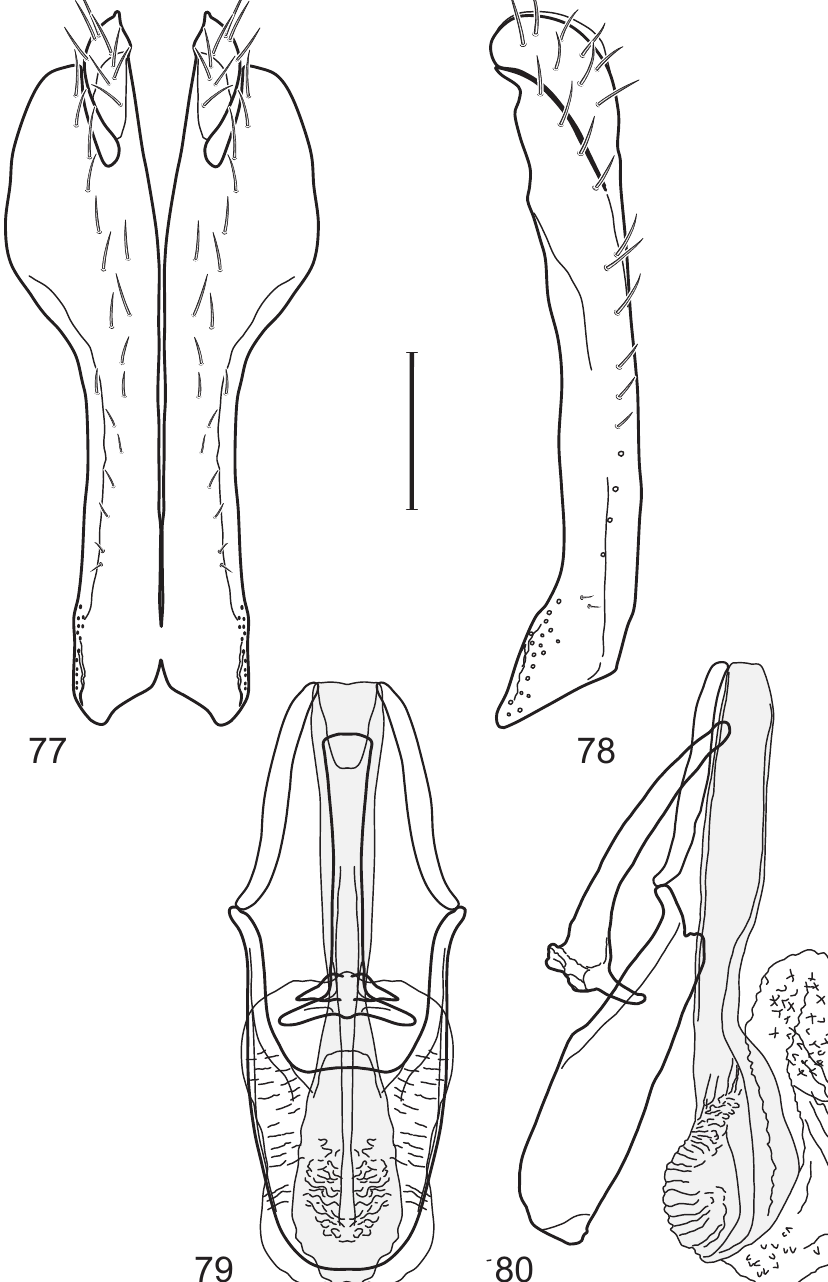
Figures 77–80. Hydrochasma dolabrutum sp. n. (Jamaica. Clarendon: Barnswell Beach) 77 epandrium and cerci, posterior view 78 same, lateral view 79 internal structures of male terminalia (aedeagus [shaded], phallapodeme, gonite, hypandrium), ventral view 80 same, lateral view. Scale bar = 0.1